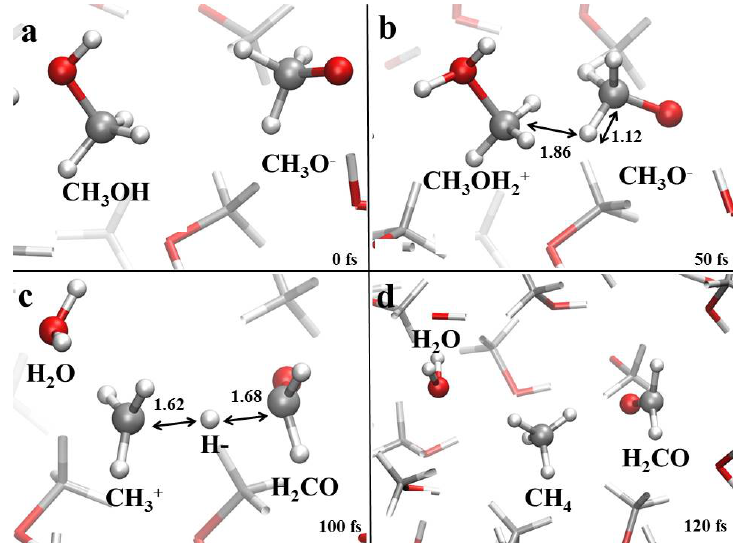
Figure 7. ( a – d ) Formaldehyde and methane formation mechanism in neat methanol and in a 75:25 methanol-water mixture under the action of a static electric field having intensity equal to 0.50